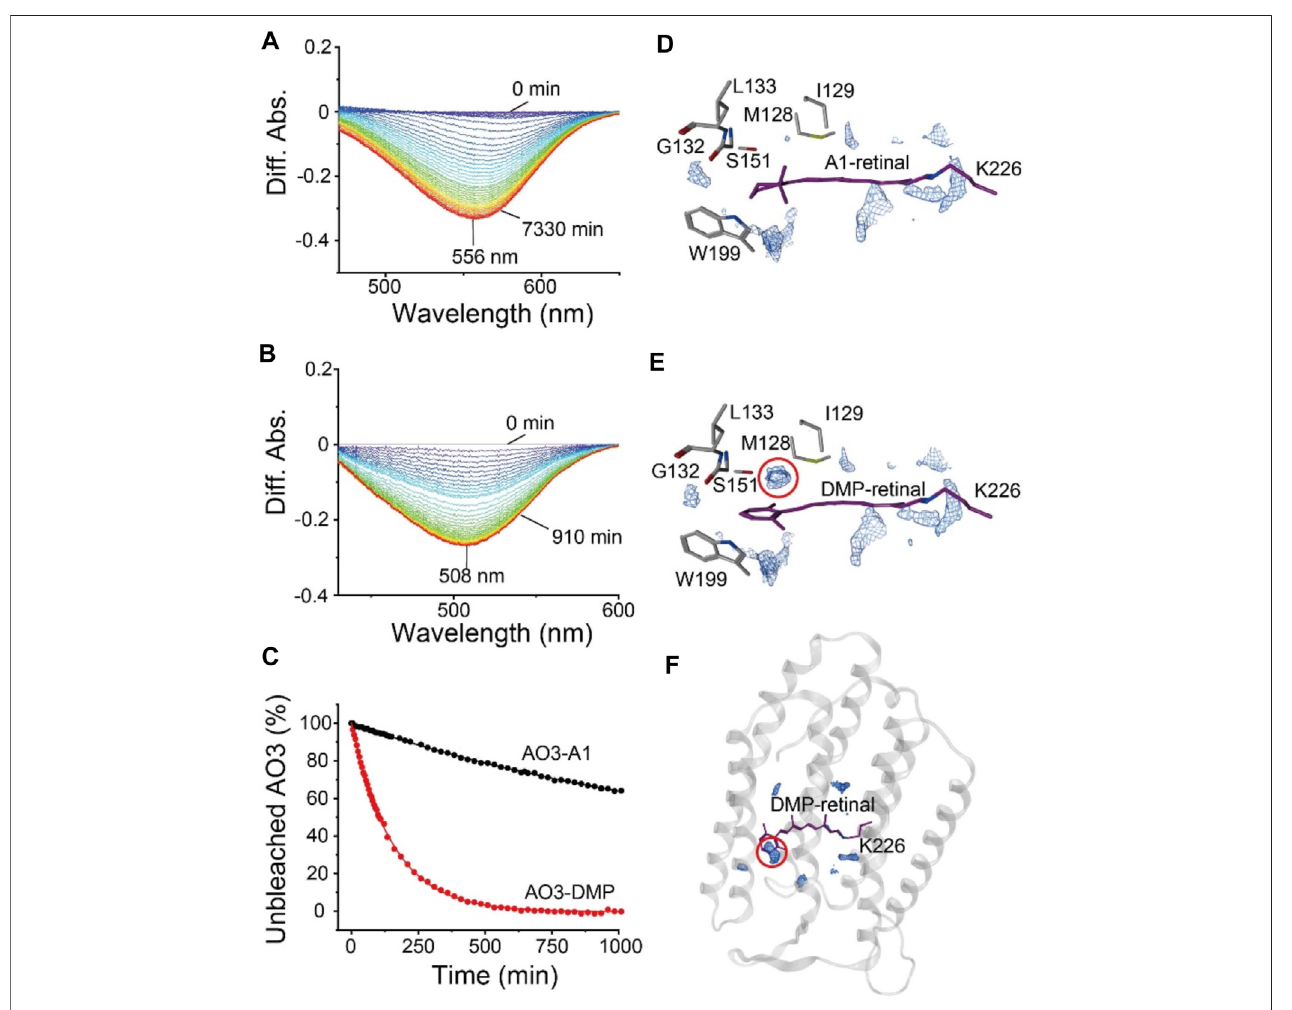
FIGURE 5 | The bleaching kinetics of AO3 with A1-retinal or DMP-retinal, induced by reaction with hydroxylamine. (A,B) Absorption spectra were recorded at various time points after the addition of hydroxylamine (100 mM) in E. coli membranes at room temperature (approx. 28 ° C). Difference spectra at each time point taking the spectra recorded at 0 min as a reference. The peaks at 556 and 508 nm correspond to the absorption maximum of the unbleached states of AO3-A1 (A) and AO3- DMP (B) . (C) Bleaching kinetics in the dark. The differences in absorption at 556 nm (AO3-A1) and at 508 nm (AO3-DMP) were plotted against their respective times. The data were fi tted with a single-exponential equation to estimate the rate constants. (D,E) Distribution pattern of water molecules (blue mesh) in the QM/MM- optimized AO3-A1 (D) and AO3-DMP structures (E) calculated using a three-dimensional reference interaction site model (3D-RISM) (Beglov and Roux,